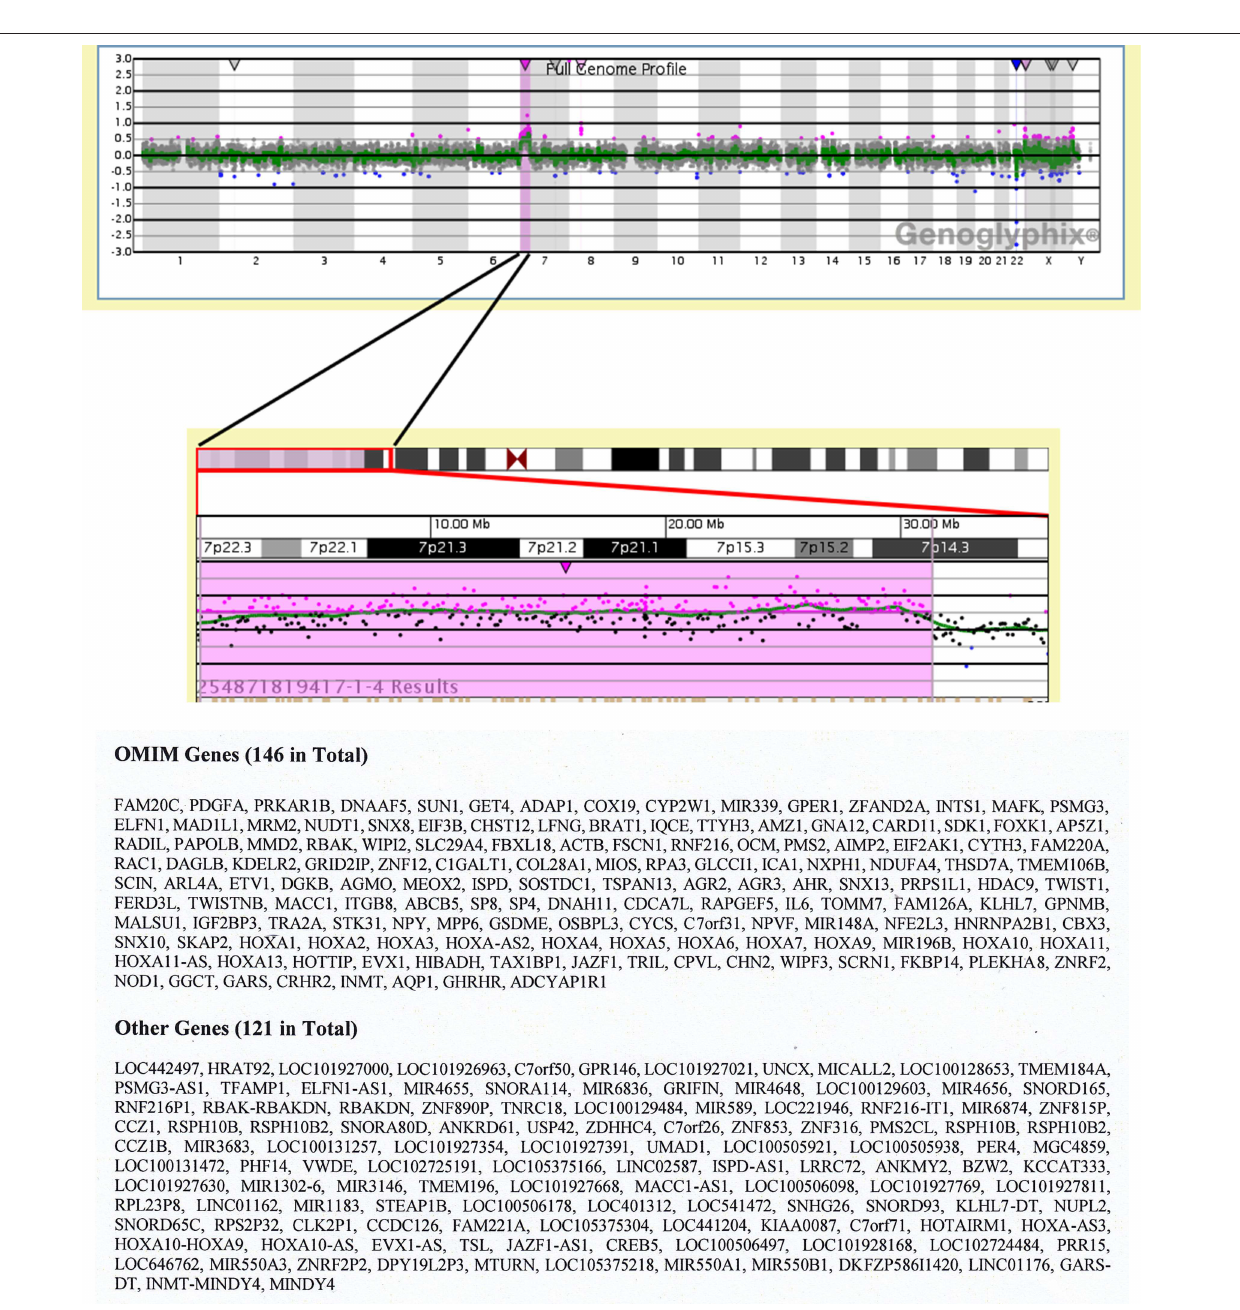
FIGURE 4 | Results of Comparative Genom Hybridization (CGH) array. Full genome profile from Genoglyphix is shown. Terminal gain of chromosome 7p22.3p14.3 Array Result: arr[GRCh37/hg19] 7p22.3p14.3(187243_31346787)x3 (upper part) . Genes located in the region of interest are listed: 146 Online Mendelian Inheritance in Man (OMIM) genes and 121 other genes (lower part)